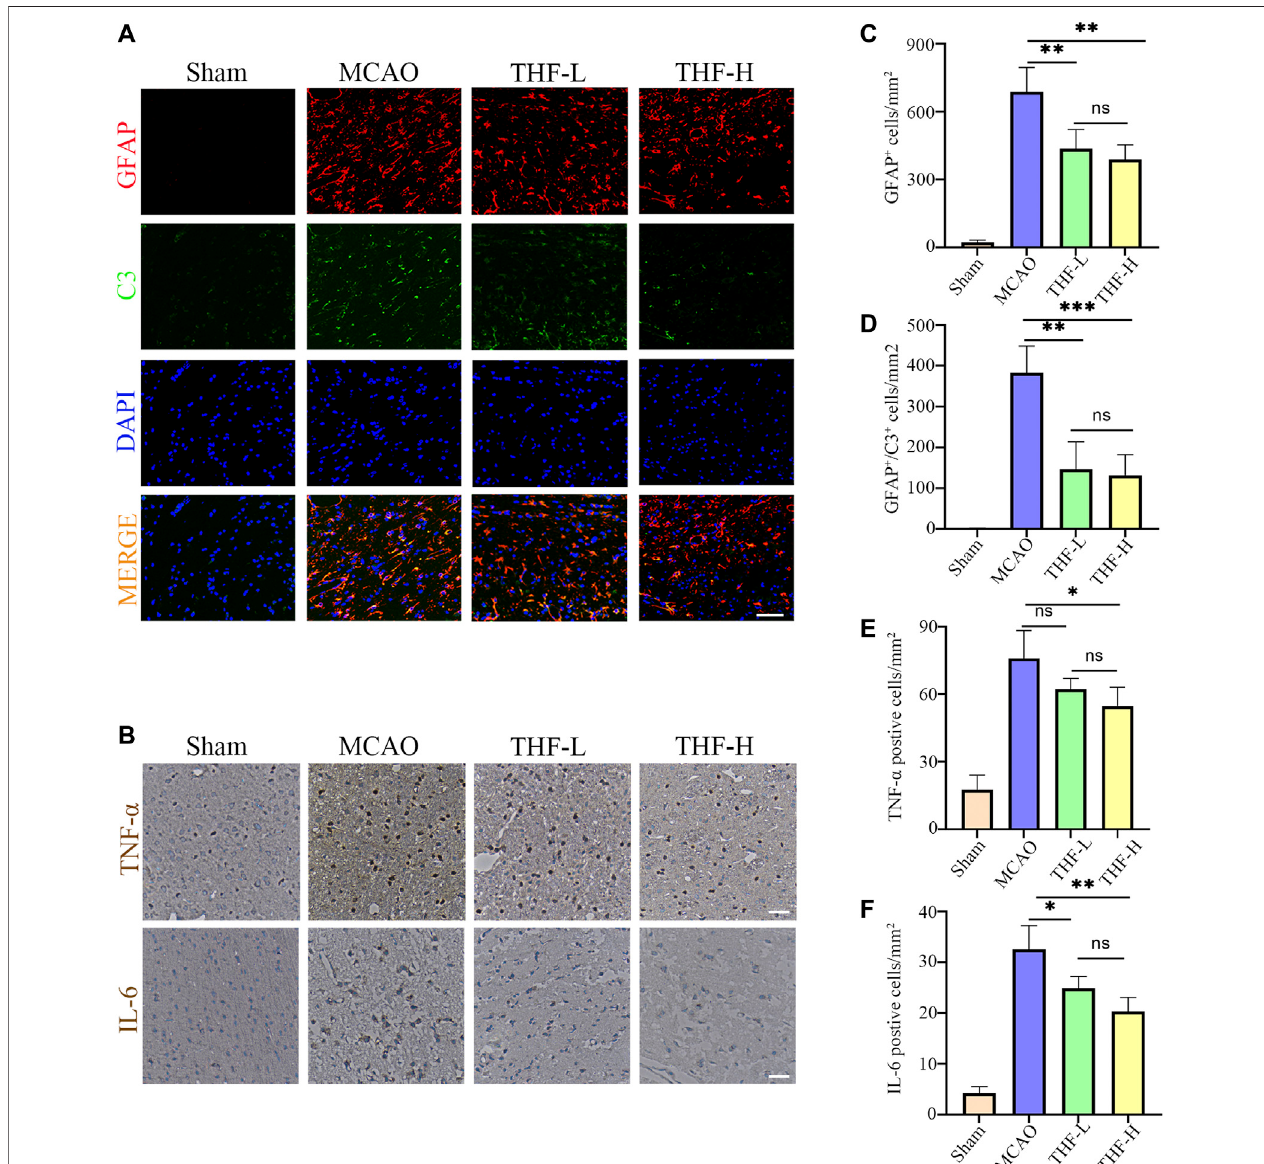
FIGURE 7 | THF inhibits the activation of A1 astrocytes and expression of IL-6 and TNF- α . (A) Representative immuno fl uorescence images represent GFAP (red) and C3 (green) staining in the cortex. GFAP, glial fi brillary acidic protein. Scale bar = 50 μ m. (B) Immunohistochemistry of IL-6 and TNF- α in the cortex. Scale bar = 100 μ m. (C) Quanti fi cationofthenumberofGFAPpositivecellsineachgroup. (D) StatisticaldiagramofGFAP/C3positivecells. (E) StatisticaldiagramofTNF- α – positive cells. (F) Quanti fi cation of the density of IL-6 – immunostained cells. IL-6, interleukin-6; TNF- α , tumor necrosis factor- α . n = 3. (* p < 0.05, ** p < 0.01, *** p < 0.001compared to the MCAO